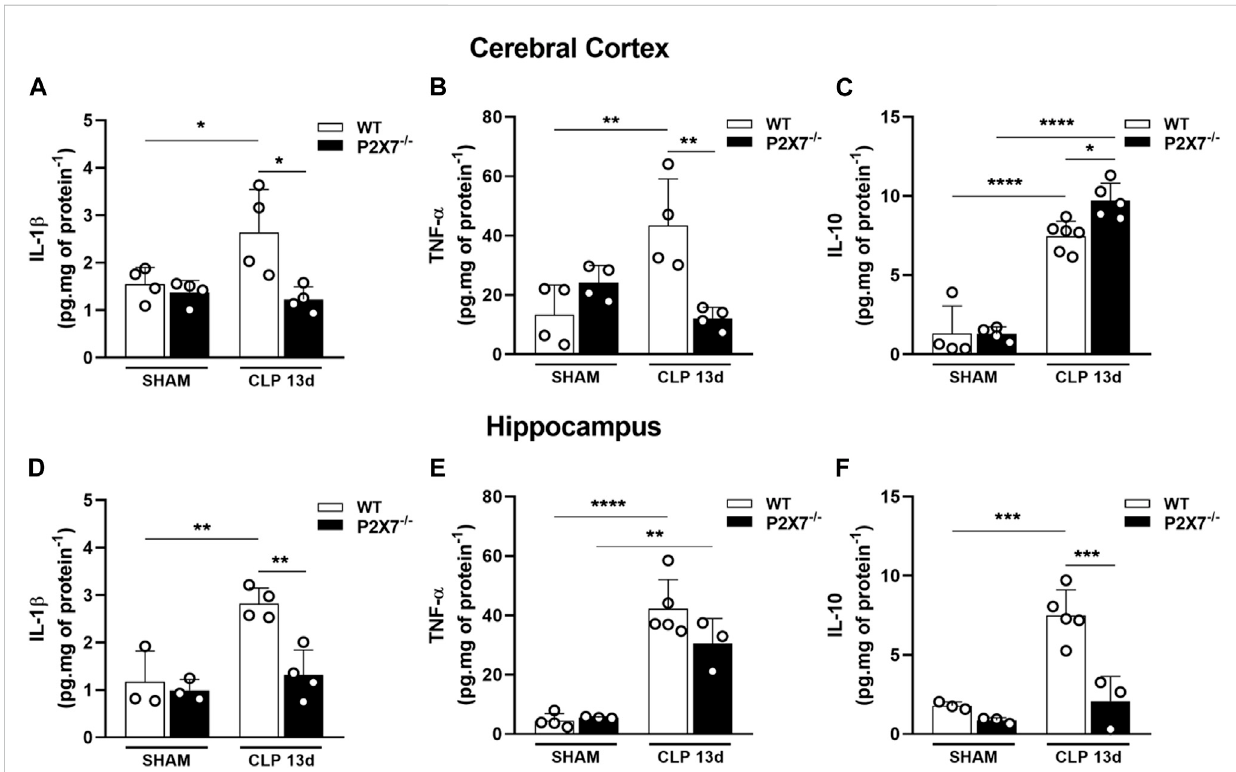
FIGURE 4 P2X7receptorgeneticdeletionreducescytokineproductioninthebrainofseptic-survivingmice.CytokineproductionIL-1 β ,TNF- α ,andIL-10were determined by ELISA in the cerebral cortex (A – C) , and hippocampus (D – F) . Data are expressed as mean ± SEM; One-way ANOVA followed by Tukey ’ s post hoc . Statistical differences between groups are represented by asterisks (* p < 0.05 ** p < 0.005; *** p < 0.0005, **** p < 0.0001). Symbols represent individual mice. ( n = 3 –